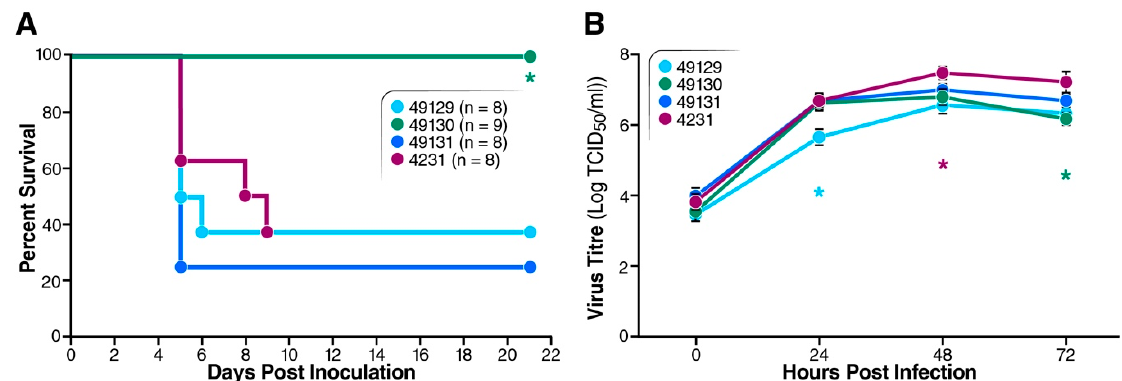
Figure 2. Characteristics of various EV-D68 strains. ( A ) Virulence test for various EV-D68 strains. Seven-day-old mice were i.p. inoculated with 100 uL of virus delivering 1 × 10 4 TCID 50 of EV-D68 strain NR-49129, NR-49130, NR-49131 or CA/14 - 4231. Survival of the mice was monitored for 21 days. Asterisk (*) represents significantly different survival curve, comparing to that of 49131-infected mice (log-rank test, p < 0.05). ( B ) Replication in RD cells. RD cells were infected with EV-D68 strains tested in Figure 2A at m.o.i. of 0.01 and harvested at 0, 24, 48 and 72 h for TCID 50 to determine virus titers. Results of triplicates are shown as mean ± S.D. Asterisks represent significant differences in virus titers compared with 49131 (Student’s t test, p < 0.05).